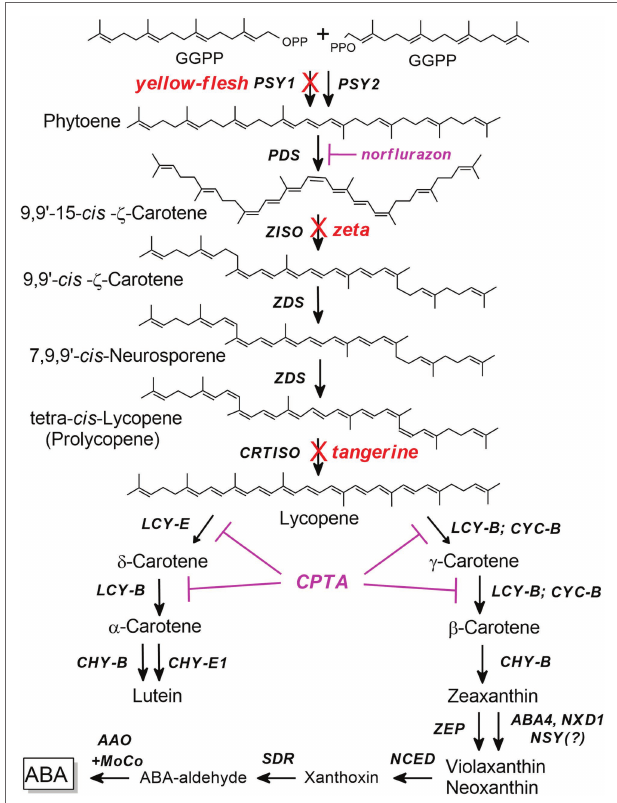
FIGURE 1 | The carotenoid biosynthesis pathway in tomato. AAO, abscisic aldehyde oxidase; ABA, abscisic acid; ABA4, involved in neoxanthin synthesis; CHY-B, β -carotene hydroxylase, CHY-E- ε -carotene hydroxylase, CRTISO, carotene isomerase; CYC-B, chromoplasts-specific lycopene β -cyclase; GGPP, geranylgeranyl diphosphate; LCY-B, lycopene β -cyclase; LCY-E, lycopene ε -cyclase; MoCo, molybdenum cofactor; NCED, 9-cis- epoxycarotenoid dioxygenase; NSY, presumed neoxanthin synthase; NXD1, involved in neoxanthin synthesis; PDS, phytoene desaturase; PSY, phytoene synthase; SDR, short-chain alcohol dehydrogenase/reductase; ZDS, ζ -carotene desaturase; ZEP, zeaxanthin epoxidase, ZISO, ζ -carotene isomerase. Mutations that interrupt the pathway are indicated in red and inhibitors in